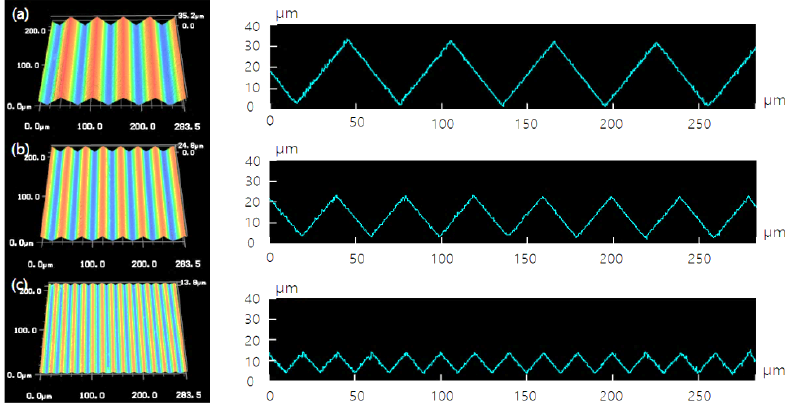
Figure 3. Confocal microscopy images of the fabricated pattern on the mold with ( a ) 10 μ m, ( b ) 20 μ m, and ( c ) 30 μ m depths.